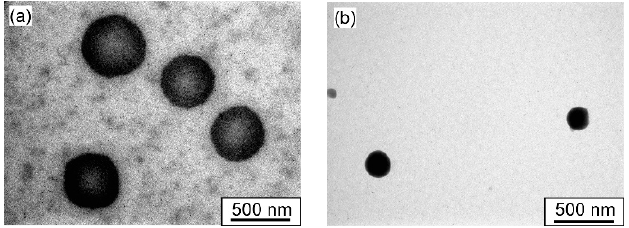
Figure 7. Transmission electron microscopy (TEM) images for ( a ) PMEA and ( b ) P(MEA/MPC 6 ) at C p = 1.0 g/L in water.